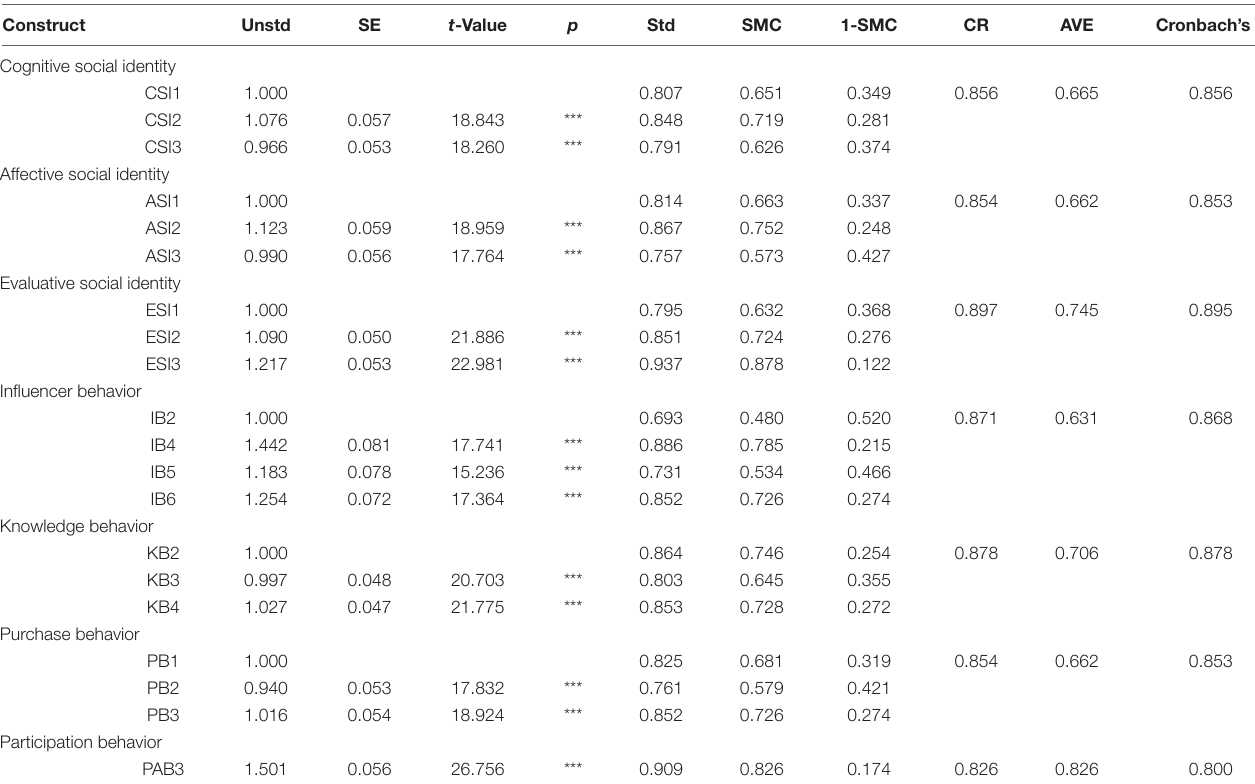
TABLE 3 | Convergent validity.